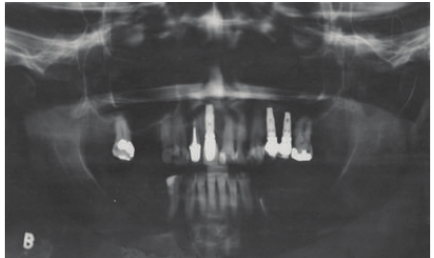
Figure 6: Final panoramic radiography (May